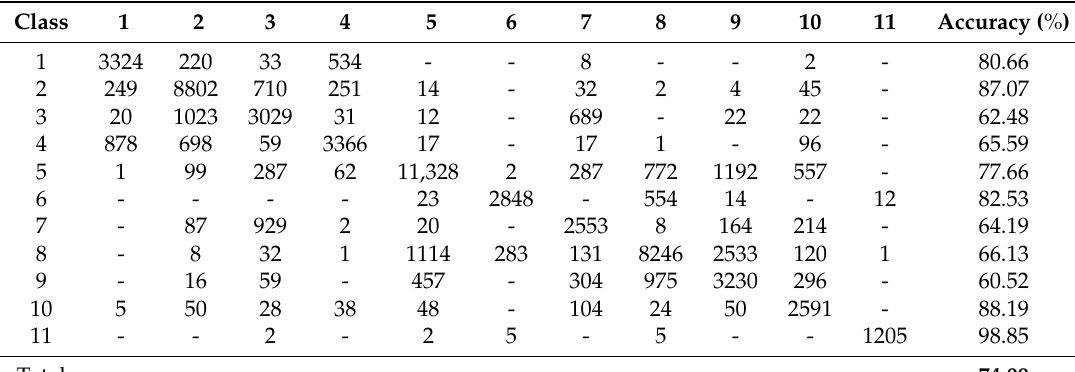
Table 3. Confusion matrix for Flevoland I data using NRS.